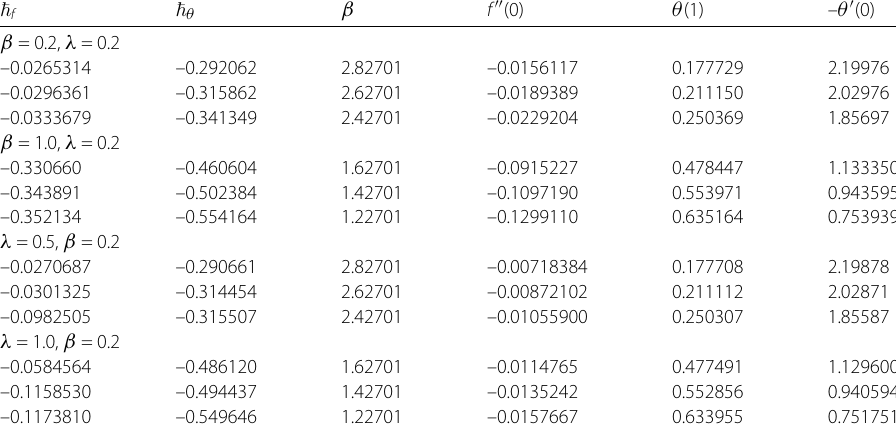
1 (cid:7)(cid:7) (0), θ (1), and – θ (cid:7) (0) using 20th-order HAM via Mathematica package Table 4 Variation of β = Υ 2 , f BVPh2.0 approximation when A = 0.3, I 0 = 0, N = 0.2, S = 0.4, Ma = 1, M = 1, Pr =